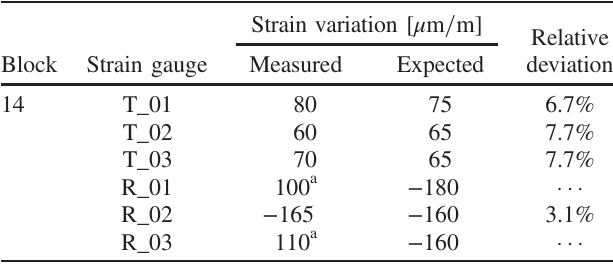
TABLE VI. The table presents the average strain variation per pulse measured at 3 . 75 × 10 12 ppp in four of the strain gauges of block 14 in the radial and transversal directions. The expected strain variation obtained through FEM calculations and the relative deviations between both values are also displayed.